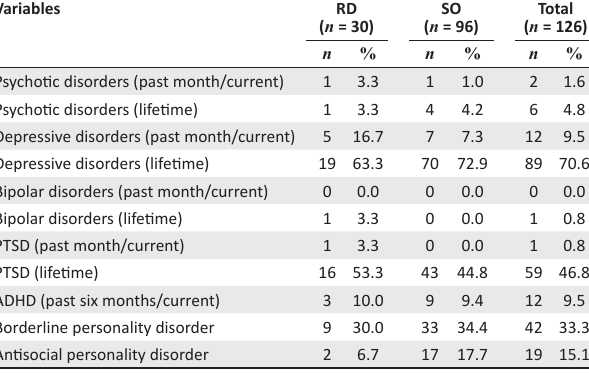
FIGURE 1: Categories of current offences. TABLE 2: Prevalence of DSM-5